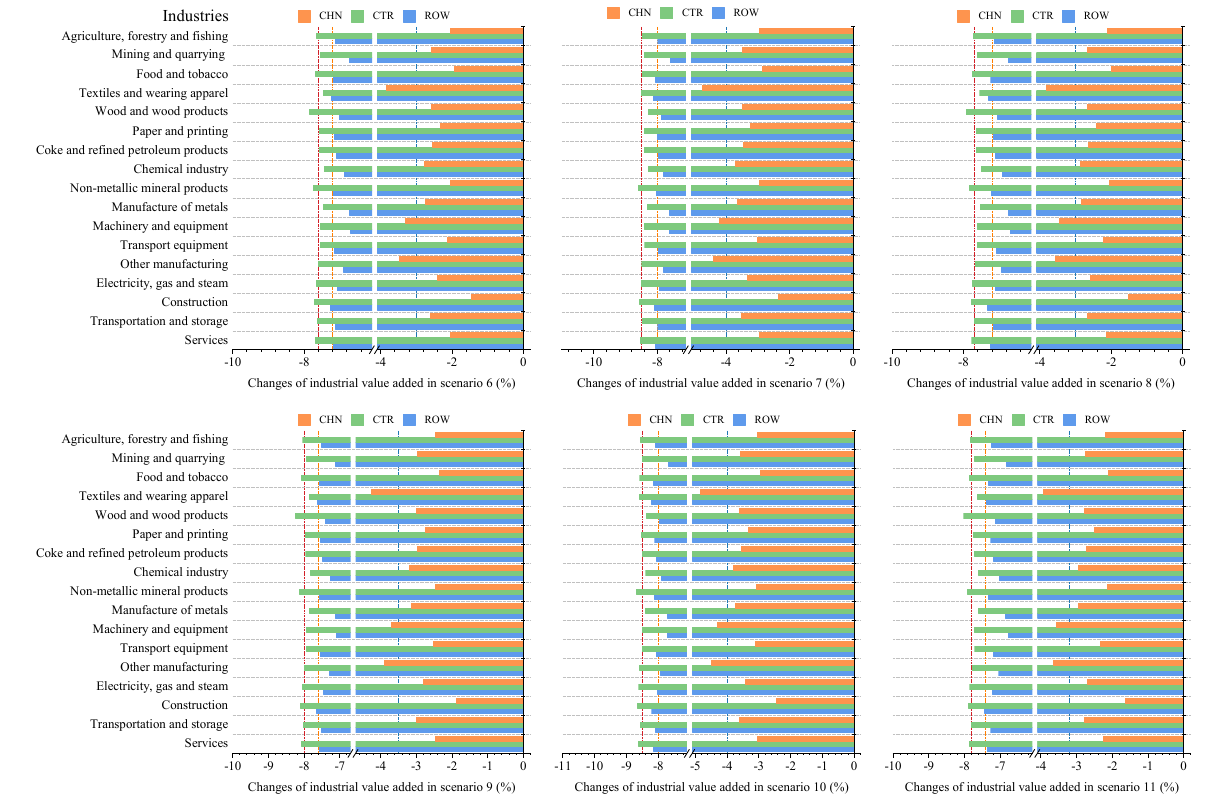
Figure 7. The impact of global pandemic spread on industrial value added in trade regions in the context of trade protectionism.